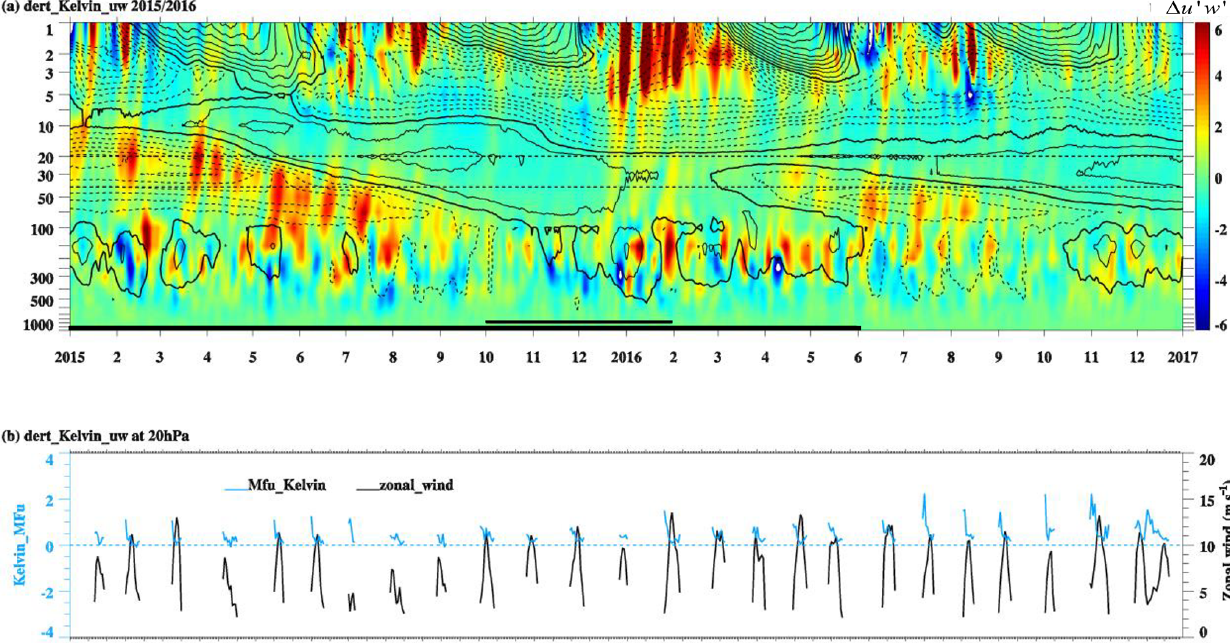
Figure 14. Temporal evolution of Kelvin wave vertical momentum flux anomalies averaged over 10 ◦ S–10 ◦ N. Panel (a) shows the daily time- altitude cross section from 2015 to 2016. Color shading denotes the anomalies with respect to the monthly climatology (unit is 10 − 3 m 2 s − 2 ). The zonal mean zonal wind is overlaid in black contours with contour interval of 5ms − 1 . The solid and dotted black contours denote westerly and easterly winds, respectively. The thick contours represent the zero wind line. In panel (a) , the horizontal dashed lines denote the altitudes of 20 and 40hPa, respectively. The horizontal solid lines denote the El Niño period (single line) and strong El Niño period (double line) in the bottom. Panel (b) shows the monthly mean Kelvin wave vertical momentum flux anomalies (blue line) and the westerly background zonal wind (black line) at 20hPa from 1958 to 2017, exclusively during the westerly QBO phase. In panel (b) , the dashed line denotes the vertical Kelvin wave momentum flux anomaly value of 0m 2 s −